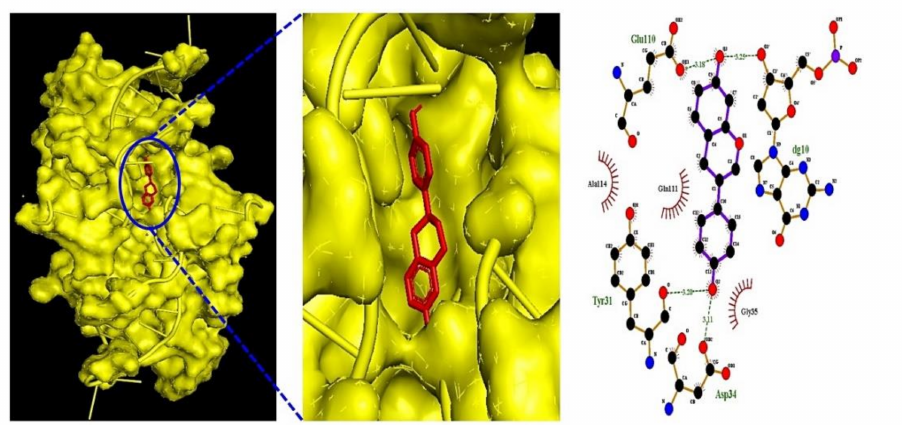
Figure 5. Equol–IL6 (PDB ID: 4NI9) complex on